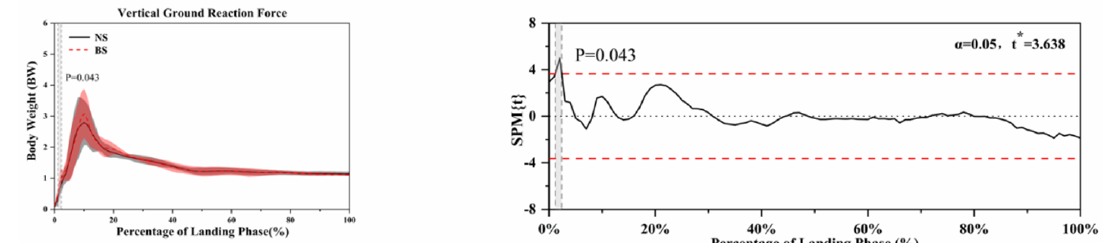
Figure 6. Descriptive results between NS and BS lower-limb statistical parametric mapping results for knee angles and moments during the SLL phase, t -values of the SPM for all participants (post hoc results; dashed red lines represent p = 0.05 level). Grey shaded areas display regions that have statistically significant differences. The scale on the left of each image shows the change in the joint angle and the value of t *. The scale of 0–100 below each image presents an SLL phase.